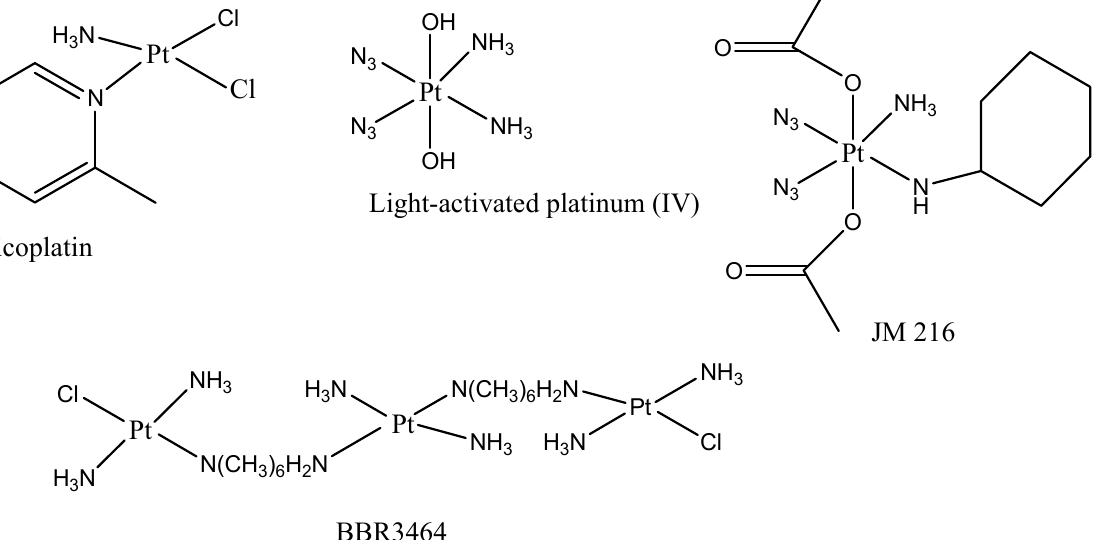
Figure 2. Unclassical platinum drugs that have been